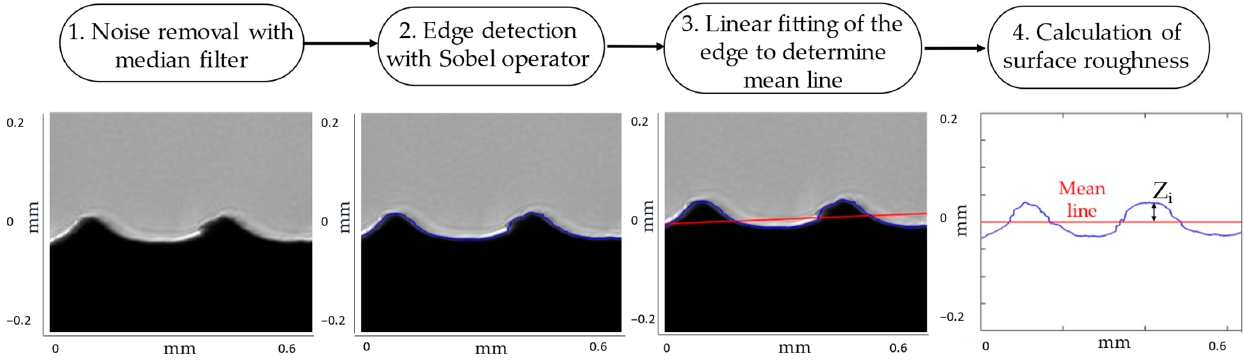
Figure 4. Steps of the measurement algorithm: (1) Filtering of the image; (2) The blue profile line is determined through the Sobel edge detection method; (3) The red line is the mean line obtained with the linear fit of the edge; (4) R a is measured as the average of the distances Z i between each i th point of the profile and the mean line.